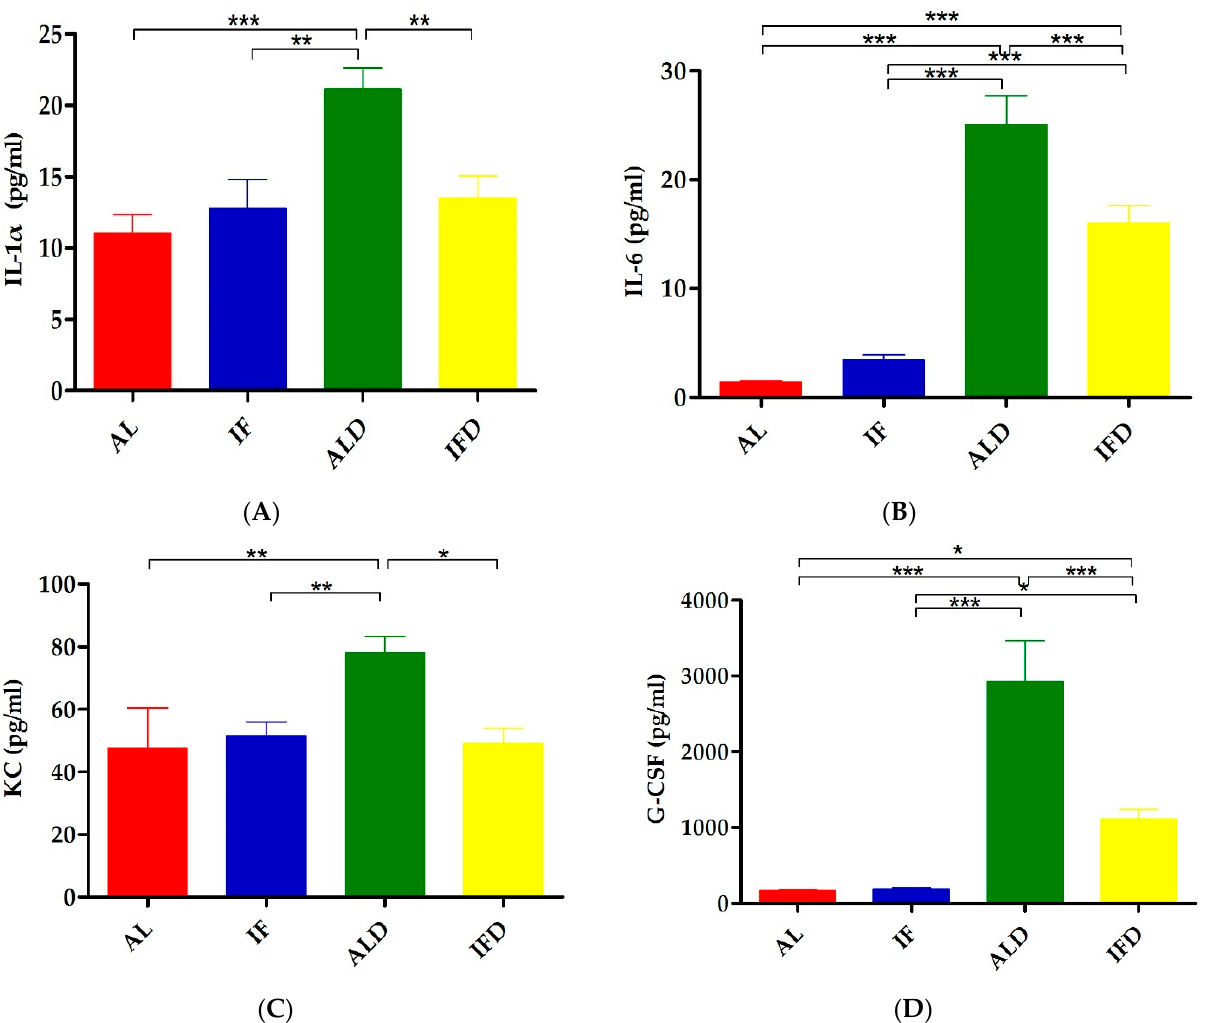
Figure 8. IF alleviates DSS-induced pro-inflammatory cytokines in serum: ( A ) concentration of IL- 1 α in the serum; ( B ) concentration of IL-6 in the serum; ( C ) concentration of KC in the serum; and ( D ) concentration of G-CSF in the serum. AL: ad libitum-fed group; IF: intermittent fasting group; ALD: ad libitum-fed group with DSS; IFD: intermittent fasting group with DSS. * p < 0.05, ** p < 0.01, *** p < 0.001.